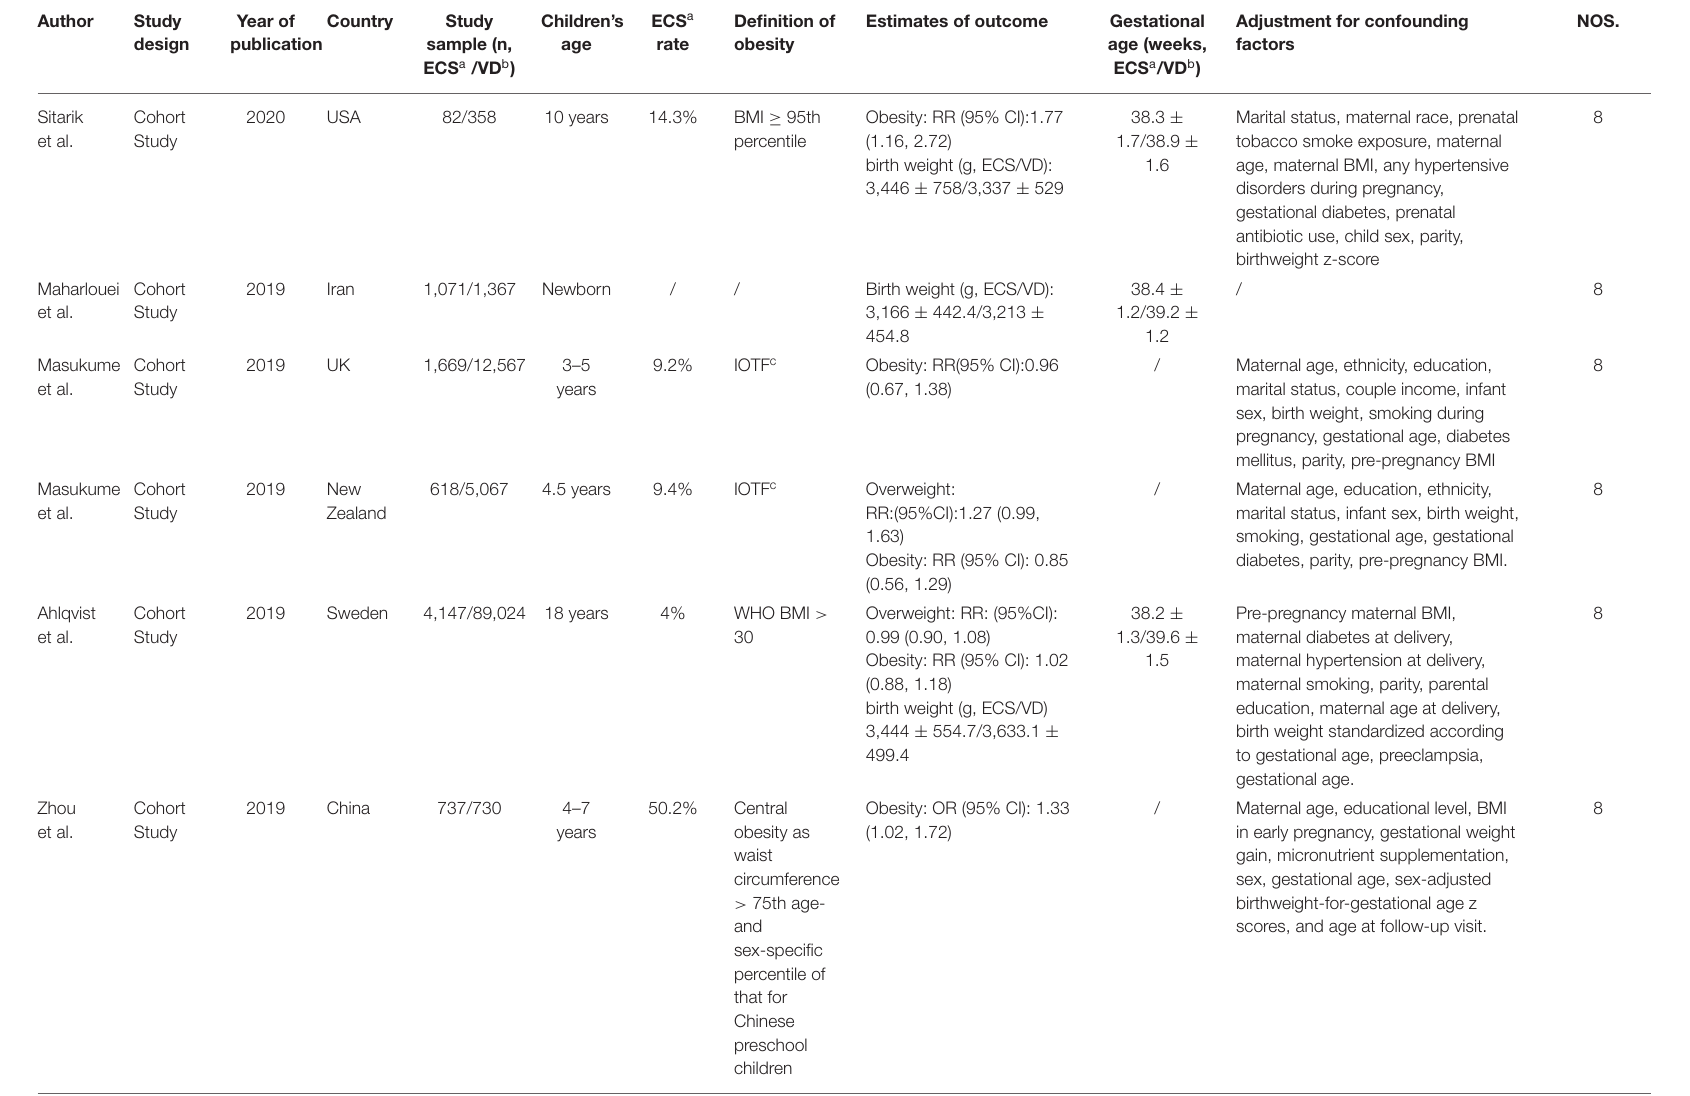
TABLE 1 | Characteristics of studies included in the